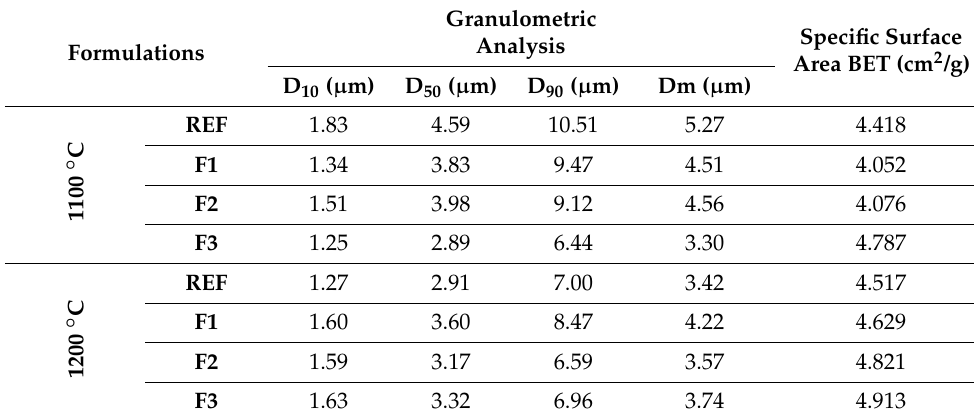
Table 4. Physical characteristics of experimental